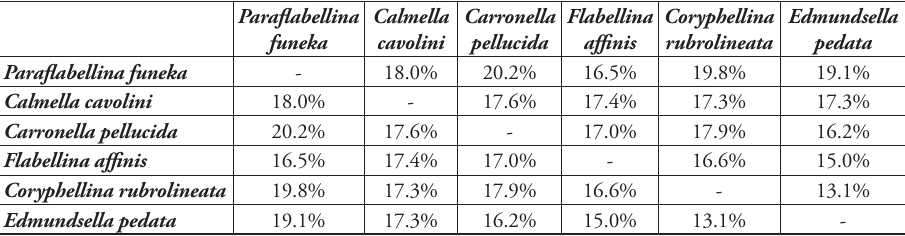
Table 2. Minimum uncorrected p-distances (%) between representatives of the genera of the family